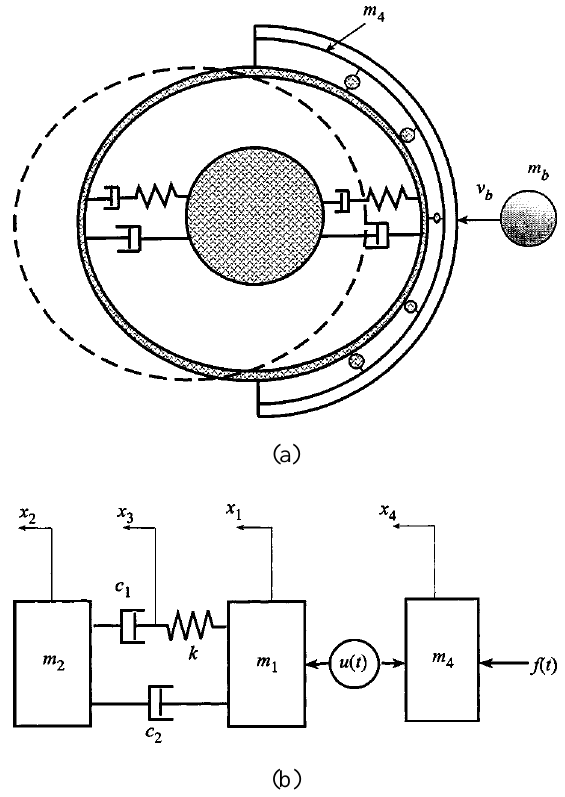
Fig. 4. Helmeted head impacted by a moving object with the head de- scribed by THIM. (a) Illustration of the problem; m 4 : effective mass of the helmet; m b : mass of the projectile, e.g., a ball. (b) Physical model for the limiting performance